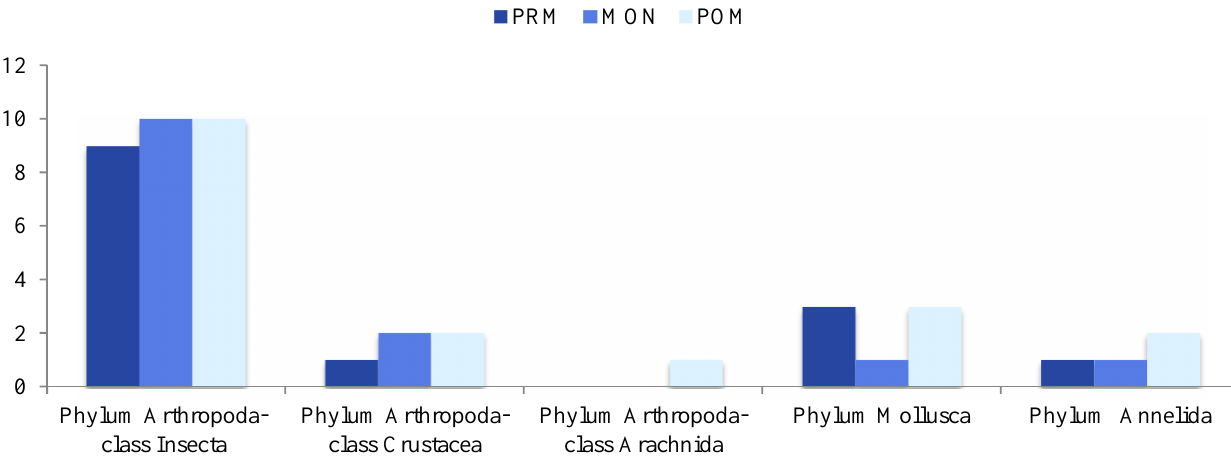
Figure 7. Seasonal variations in taxon frequency distributions PRM: Premonsoon; MON: Monsoon; POM: